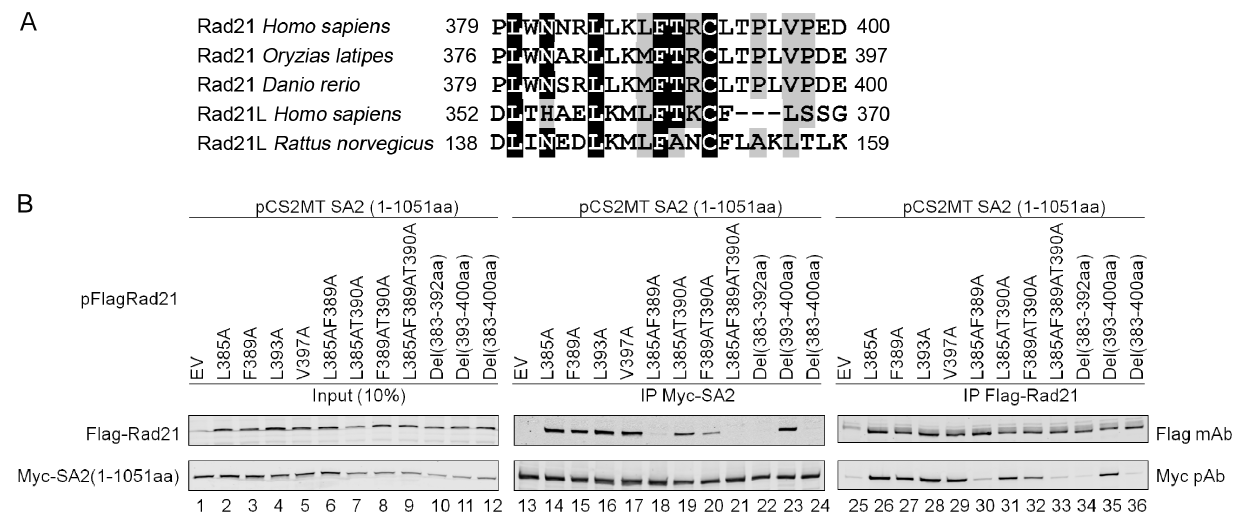
Figure 4. L 385 and F 389 are critical for Rad21 to interact with SA2. ( A ) Sequence alignment of Rad21 from various vertebrate species. The sequence alignment was prepared using BioEdit (http://www.mbio.ncsu.edu/bioedit/). The conserved Rad21 L 385 , F 389 and T 390 residues were used for making site-directed mutations. ( B ) Co-immunoprecipitation analysis indicating the importance of L 385 , F 389 , and T 390 residues on Rad21 for its interaction with SA2. Flag-Rad21 and Myc-SA2(1–1051 aa) were expressed in 293 T cells. Co-IP was performed 48 h after